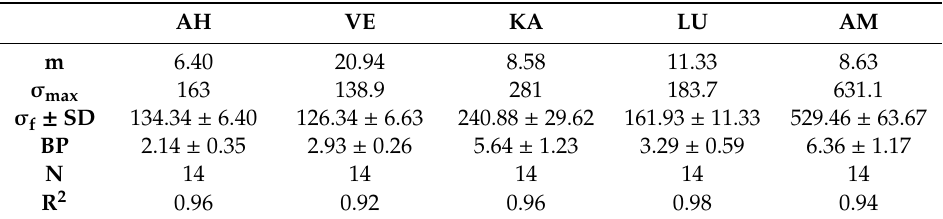
Table 3. Weibull analysis of biaxial flexural